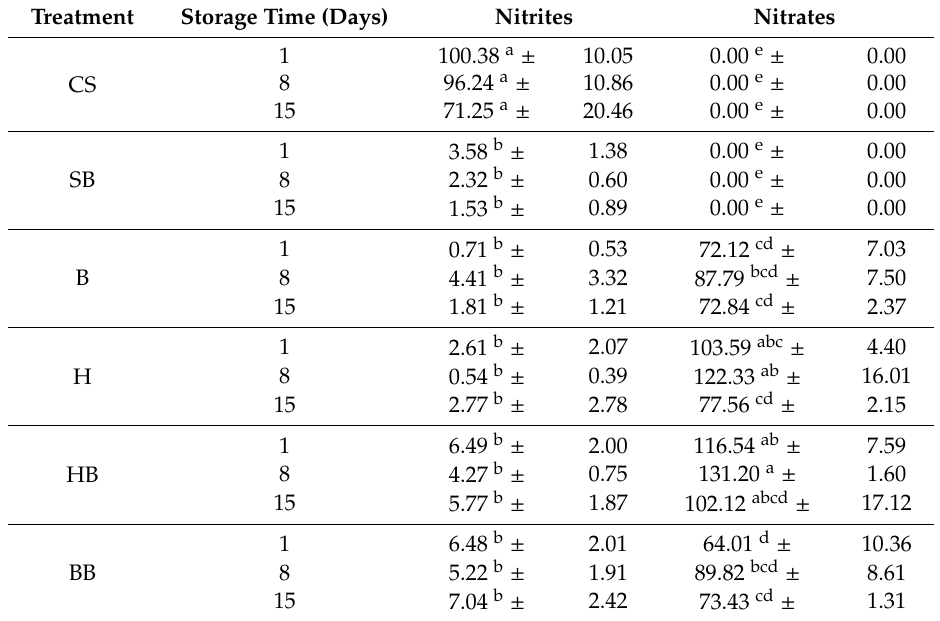
Table 5. Nitrites and nitrates content in meat samples (mg / kg) (mean values ± standard errors (SE)).